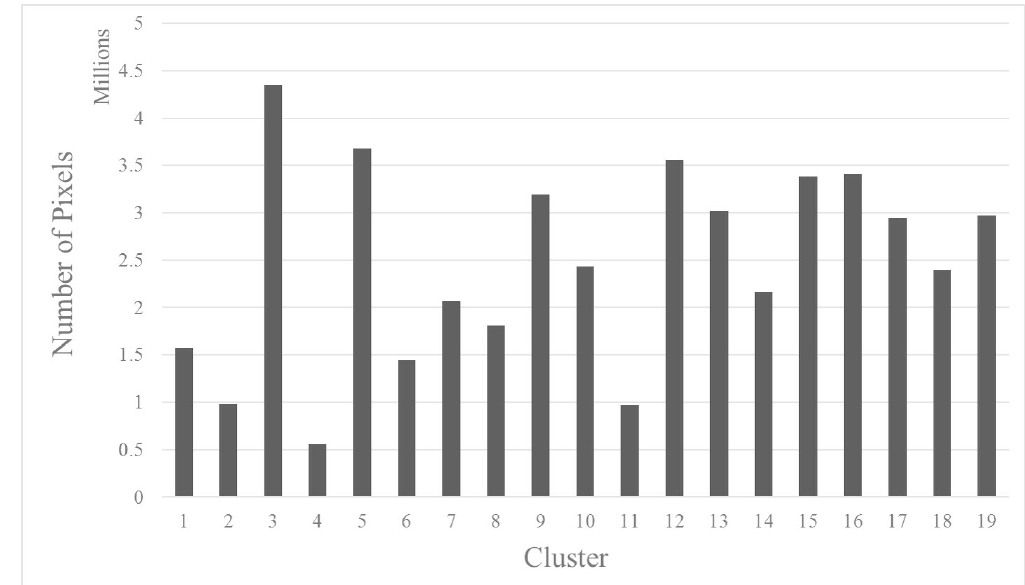
Figure 4. Number of pixels in each North African cluster.